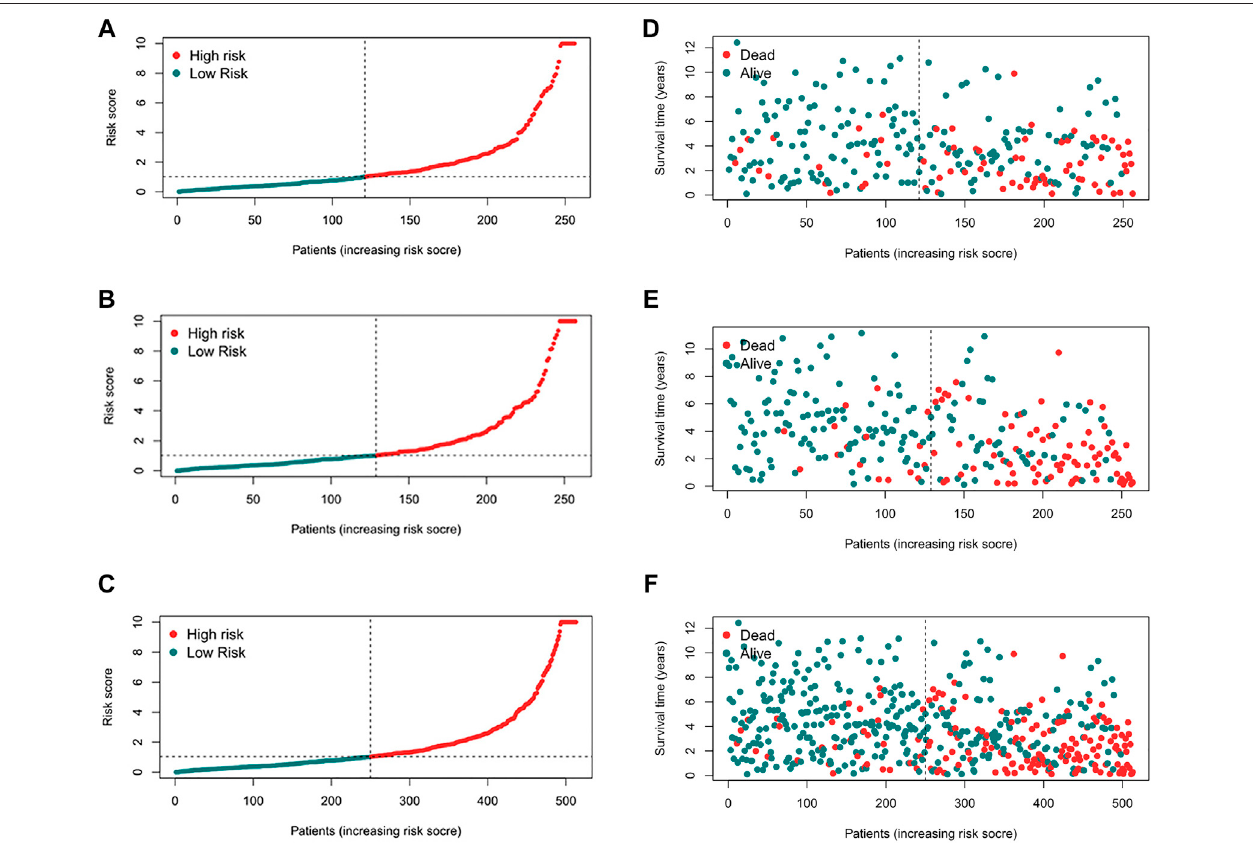
FIGURE 4 | Prognosis value of the 12 m7G-related lncRNAs model in the test, train, and entire set (A – C) Exhibition of m7G-related lncRNAs model based on risk score ofthe test, train, and entire set,respectively, (D – F) Survival status and timeofpatients between twogroups in thetest, train, and entireset, respectively, (G – I) The heatmap of 12 m7G-realted lncRNAs between two groups in the test, train and entire set, respectively, (J – L) The survival curve of patients between two groups in the test, train and entire set, respectively, (M) Survival curves strati fi ed by age, gender, grade, stage, T, N, or M between two groups in the entire set.